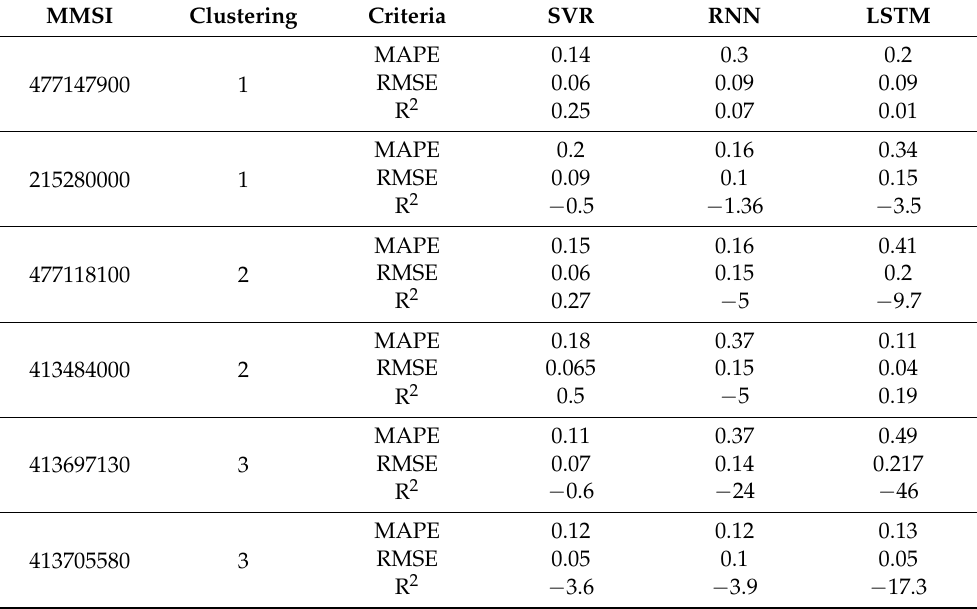
Table 5. Vessel trajectory prediction errors based on the whole set for different models on six vessels.